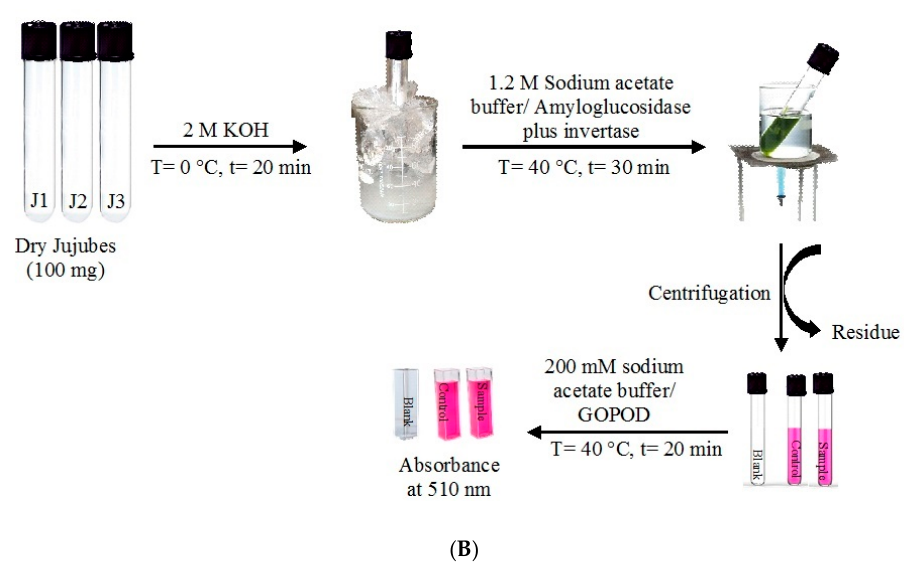
Figure 2. ( A ) Total glucan content and ( B ) α -glucan content.